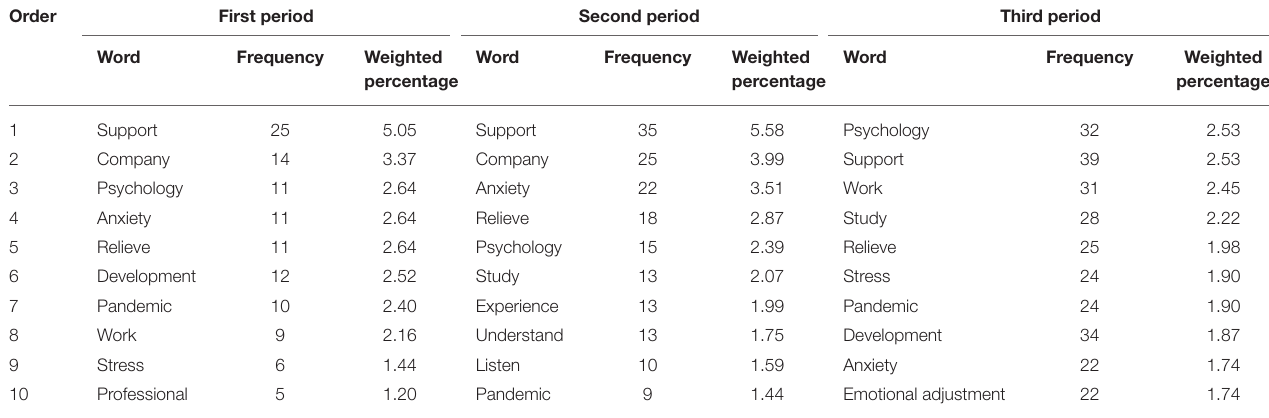
TABLE 2 | The demands of group members at three